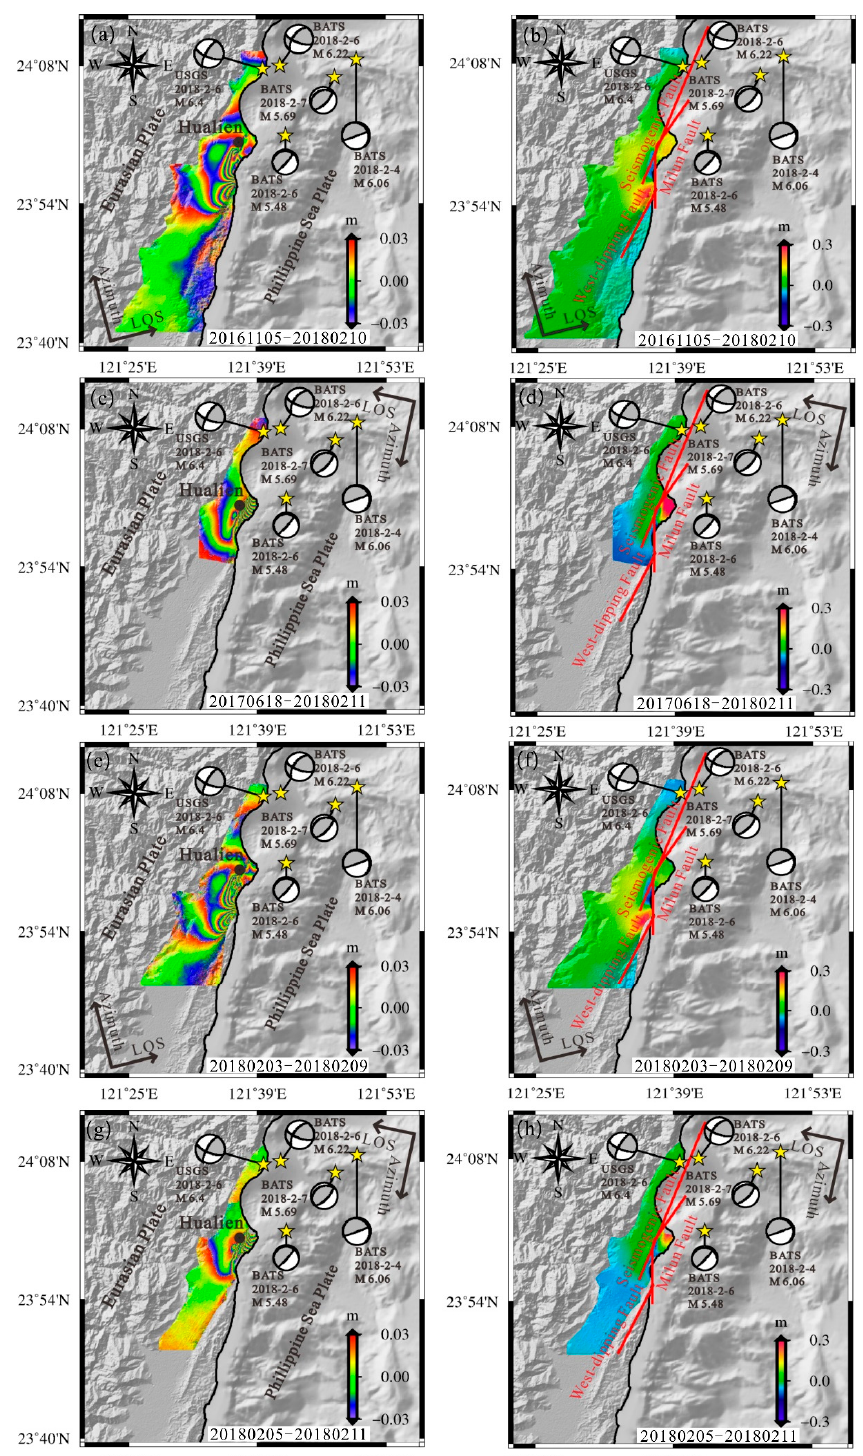
Figure 2. Mapped surface deformation fields of the 2018 Hualien earthquake using the ALOS-2 and Sentinel-1 SAR images. ( a ) ALOS-2 ascending, ( c ) ALOS-2 descending, ( e ) Sentinel-1 ascending, and ( g ) Sentinel-1 descending InSAR deformation is wrapped by [–3.0 cm, 3.0 cm]. ( b ), ( d ), ( f ) and ( h ) are the absolute InSAR deformation fields of the 2018 Hualien earthquake. The yellow star indicates the epicenter of the 2018 Hualien earthquakes and major aftershocks, and the beach balls are the focal mechanisms of the main shocks and major aftershocks of the 2018 Hualien events solved by USGS and